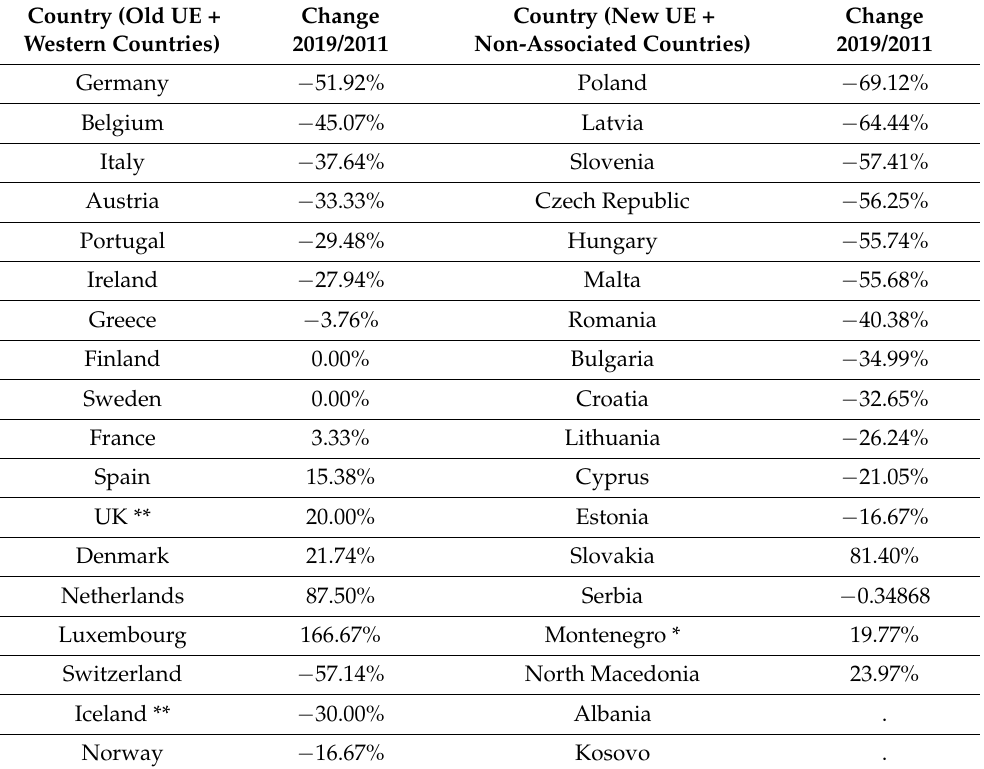
Table 4. Change in the percentage of people who have problems maintaining an appropriate temperature at home: 2019 compared to 2011